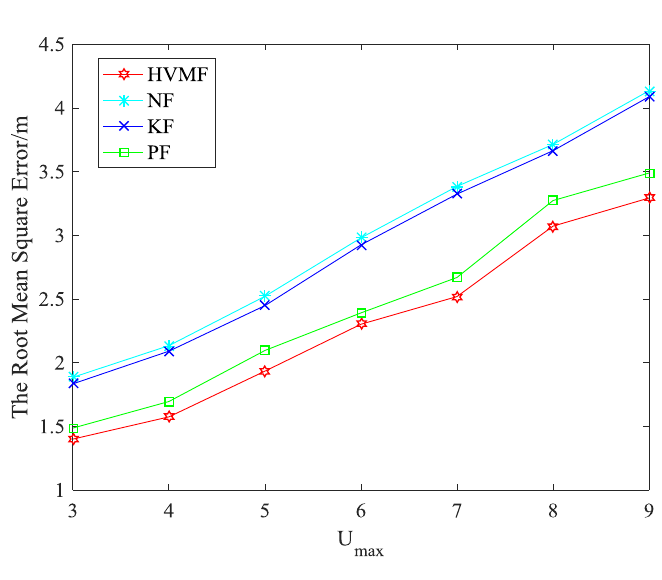
Figure 16. RMSE versus U max